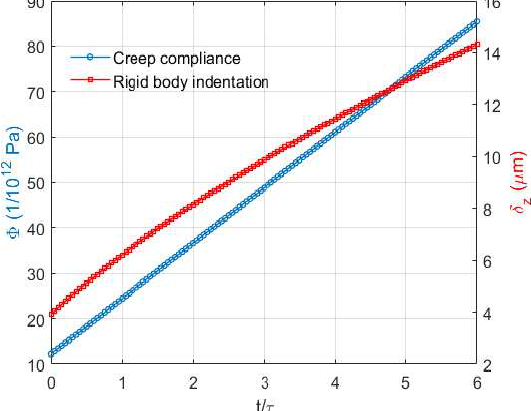
Figure 10. Changes in the creep compliance Φ ( y axis right ) and the resulting rigid body indentation δ z ( y axis right) with time.